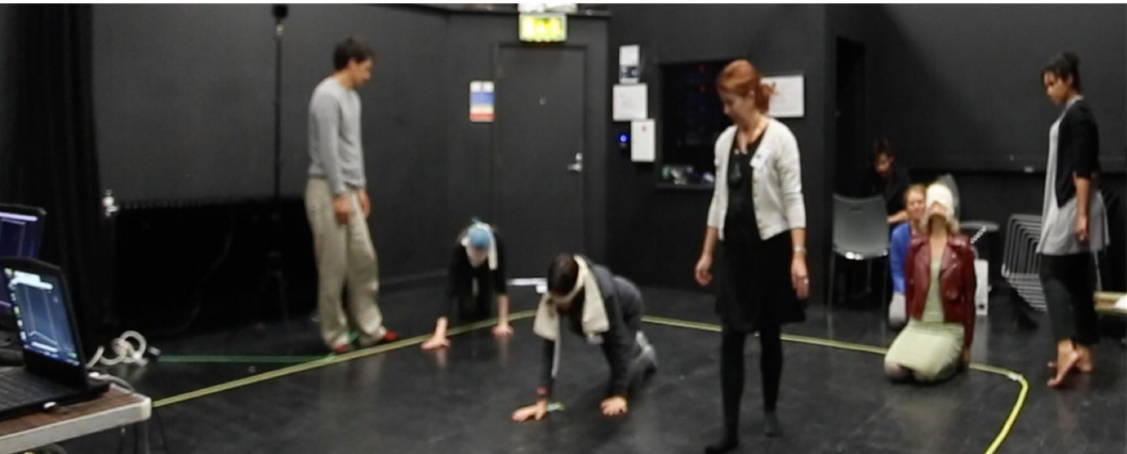
Figure 1. WOS workshops, Bodily Undoing Symposium, Bath Spa University, 2017 (the first